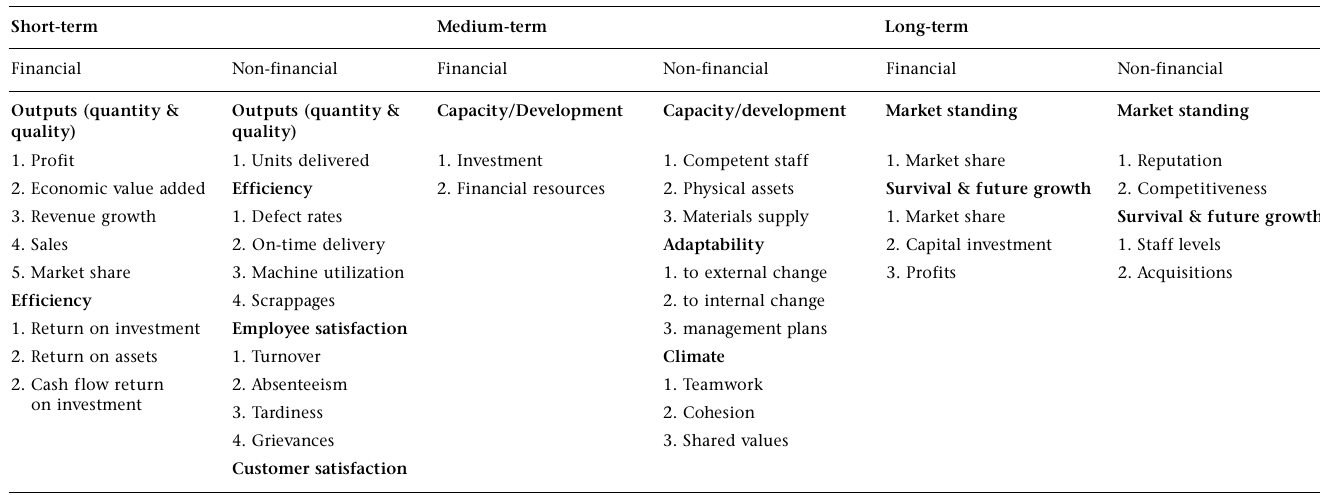
Figure 1: An adapted time-dimension model of financial and non-financial performance